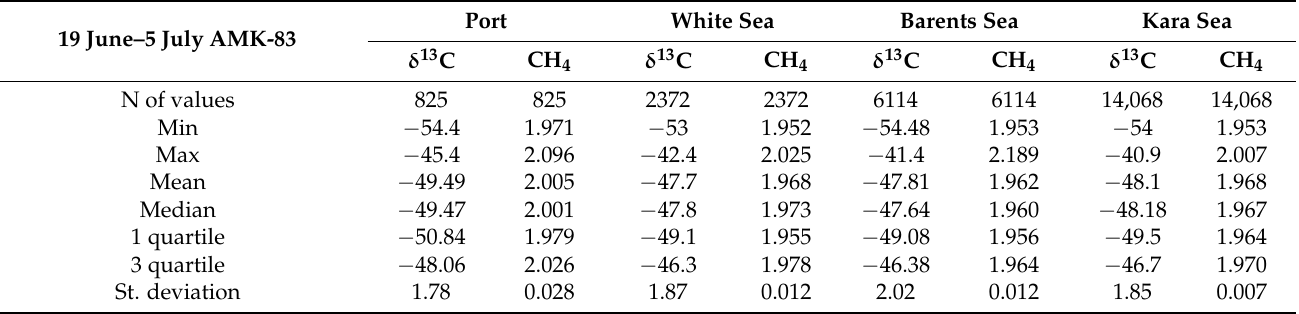
Table 1. 1-minute averaged data from sea expeditions of the R/V Akademik Mstislav Keldysh in 2021; δ 13 C (‰), CH 4